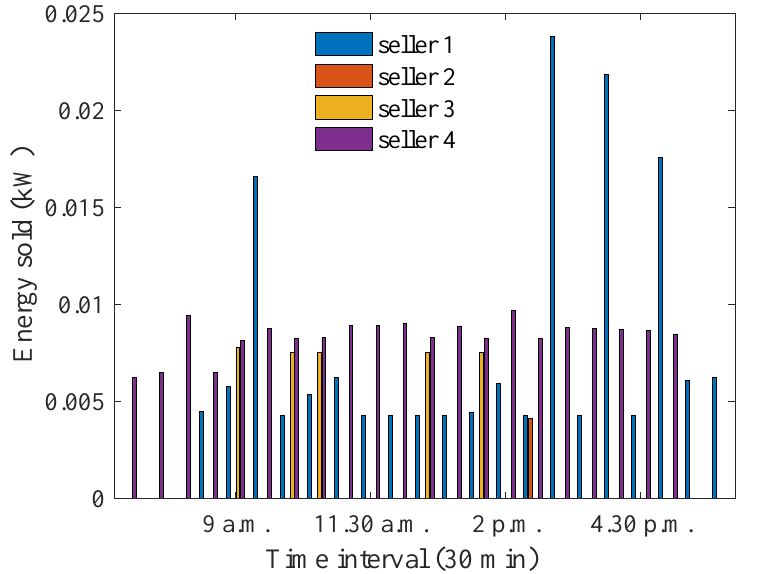
Figure 15. Optimum energy sold when distance between house 1 and the aggregator is increased.